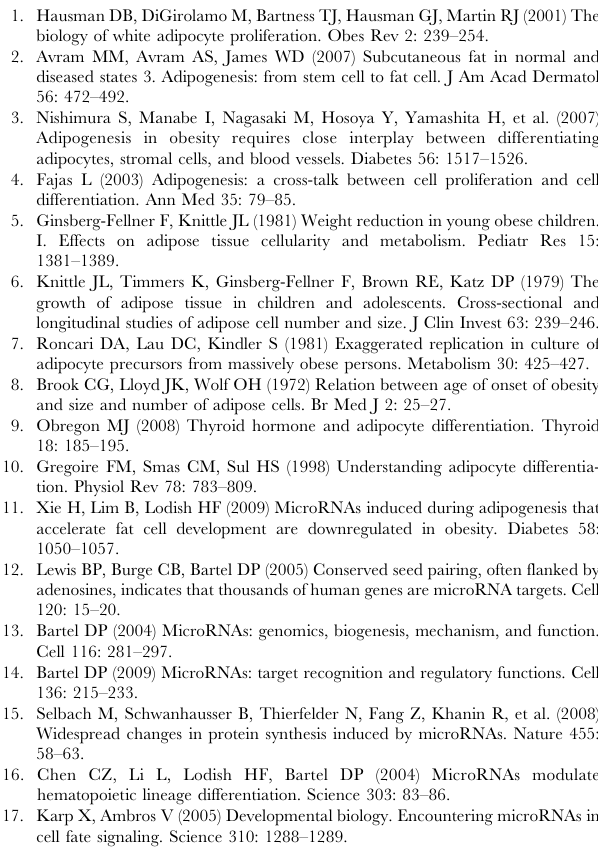
activated receptor gamma; ADIPOQ, Adiponectin; RBP4, Retinol binding protein 4. Table S1 Anthropometrical and clinical characteristics of study subjects.